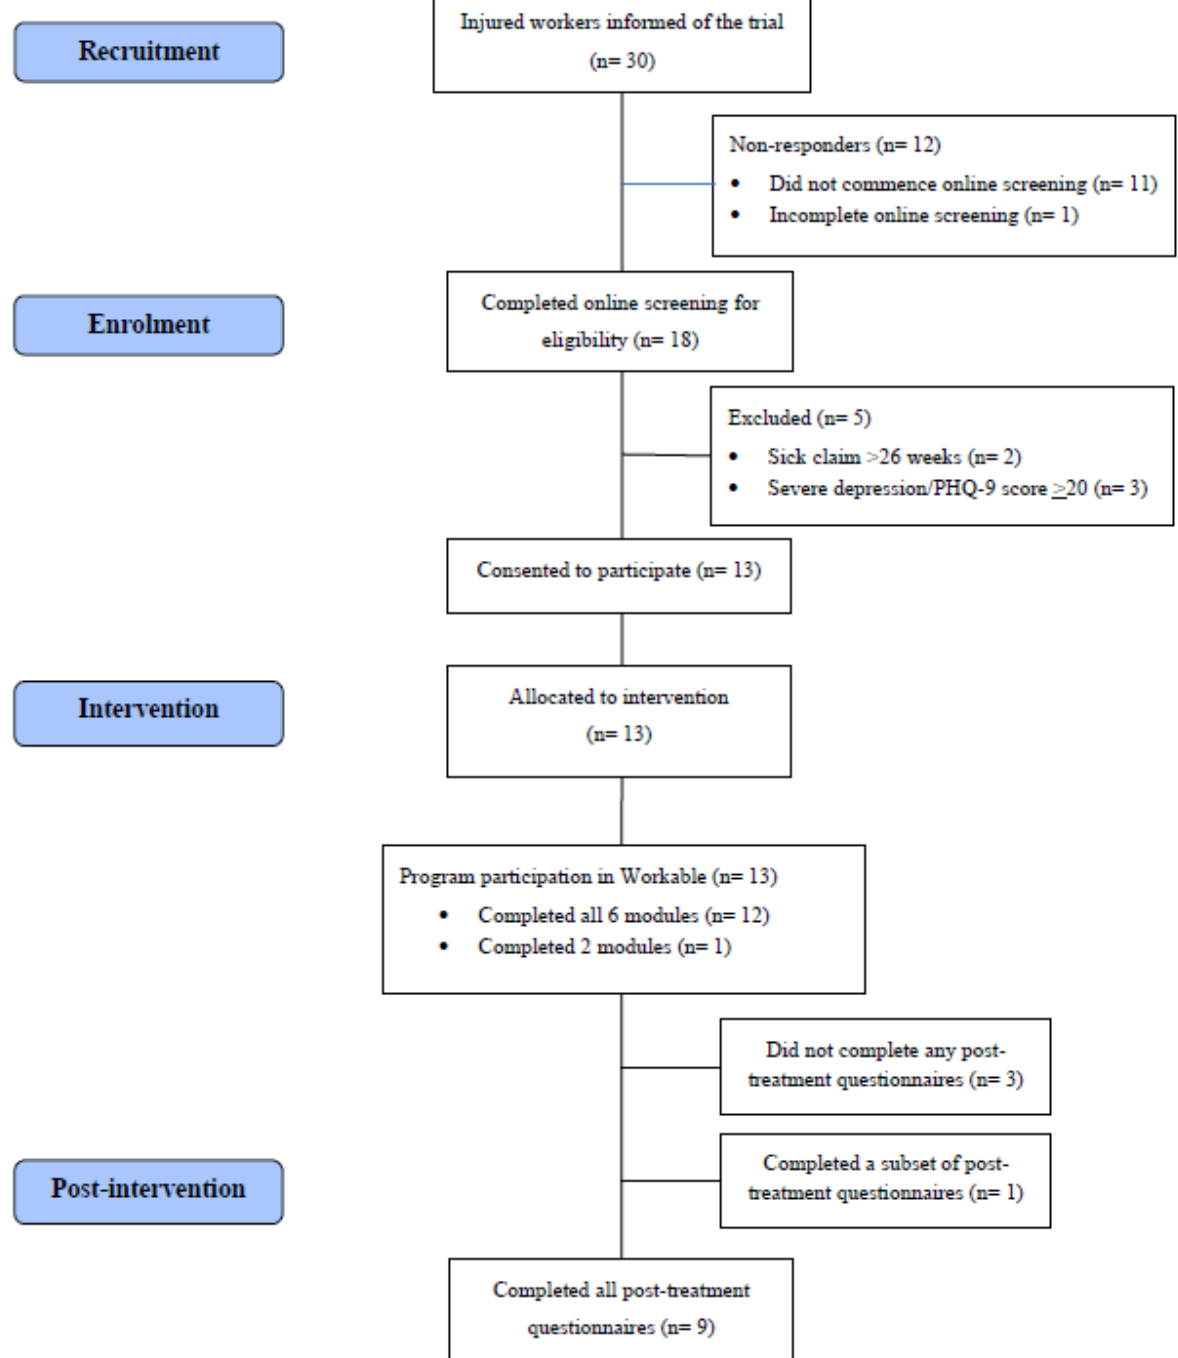
Figure 1. Flowchart of participants.